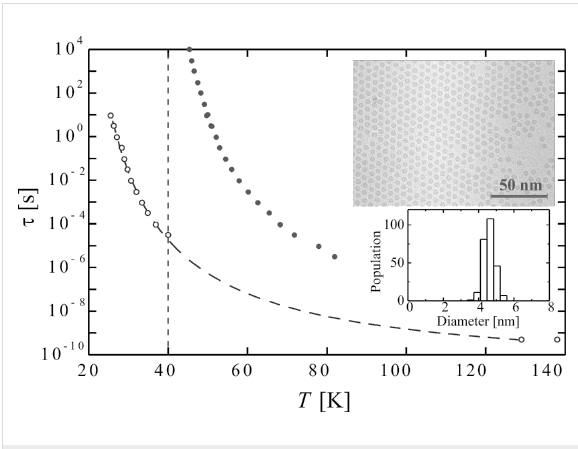
Figure 1: The relaxation time of 4.7 nm Fe 100 − x C x nearly monodis- perse particles suspended in decalin as a function of temperature. The data were obtained from AC susceptibility measurements. The open circles are data from a dilute sample, whereas the full circles are data for a concentrated sample. The insets show a transmission electron microscopy (TEM) image of the particles deposited on an amorphous carbon film and the corresponding particle size distribution obtained from the TEM images. Adapted from Djurberg, C.; Svedlindh, P.; Nord- blad, P.; Hansen, M. F.; Bødker, F.; Mørup, S. Dynamics of an Inter- acting Particle System: Evidence of Critical Slowing Down, Phys.